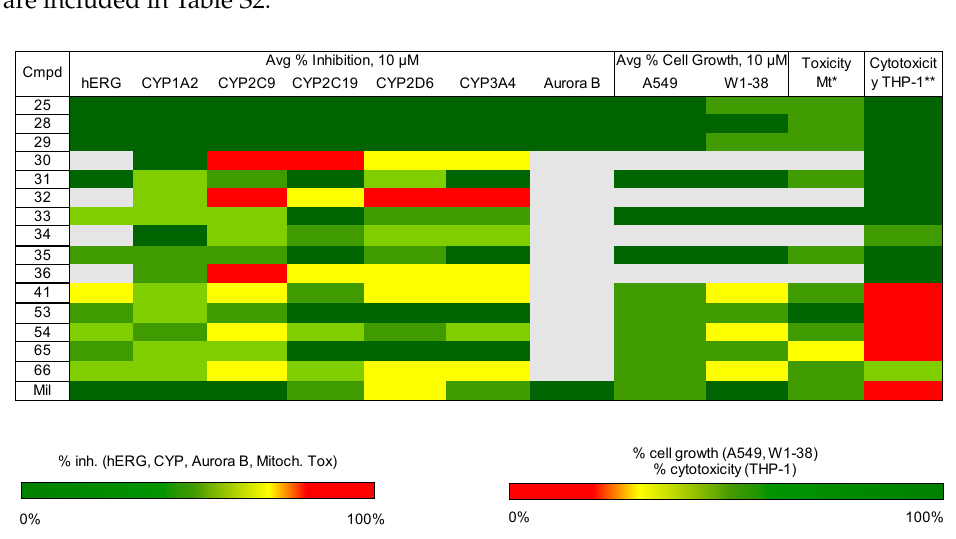
Figure 3. In vitro evaluation of toxicities (hERG, CYP1A2, CYP2C9, CYP2C19, CYP2D6, CYP3A4 and A549 and WI38 cytotoxicities) of compounds at 10 µ M and miltefosine (10 µ M or 1 µ M). The compound with the best profile is that with dark green boxes in all assays. The grey colour cor- responds to non-tested compounds. * Average % of mitochondrial toxicity 10 µ M. ** Cytotoxicity THP-1 macrophages.